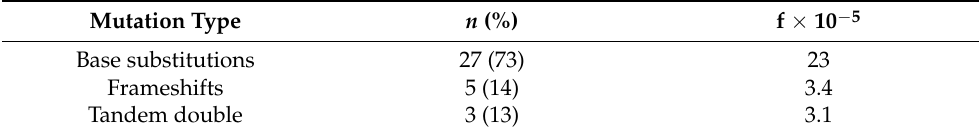
Table 4. Types of mutations in the CAN1 locus after UV irradiation of hsm3 Δ mutant